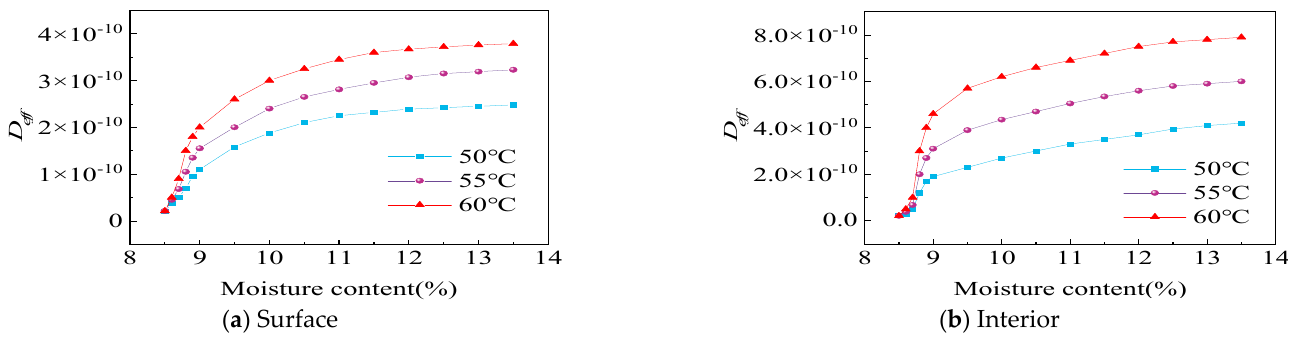
Figure 12. The variation in effective moisture diffusivity with moisture content at different temper- atures. ( a ) The heaped tobacco strips’ surface ; ( b ) the heaped tobacco strips’ interior. In other fields, the influence of temperature on effective moisture diffusivity has been studied [34,35]. The logarithm was taken based on Equation (20), and written as Equation (23):